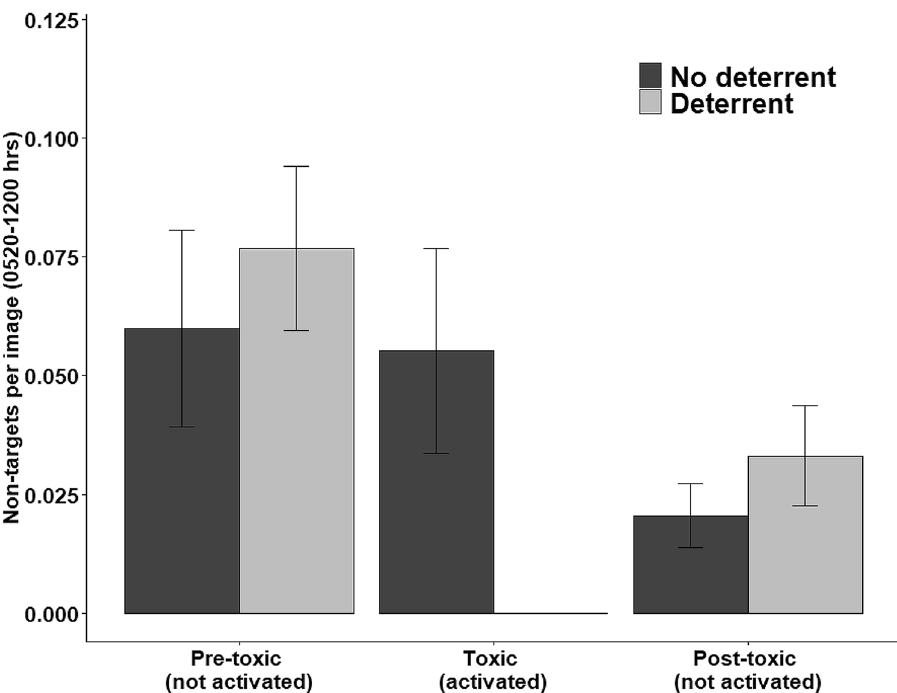
Figure 5. Index of non-target animals (primarily birds) using bait sites pre-, during, and post-activation of a deterrent device during the hours of 0520–1200 at sodium nitrite toxic bait sites in north-central Texas, USA during July